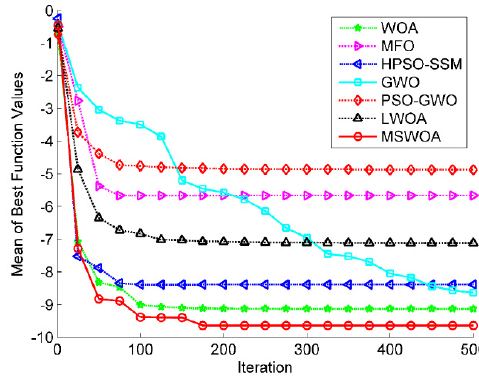
Figure 12. Optimization results for F18 (Dim = 6).